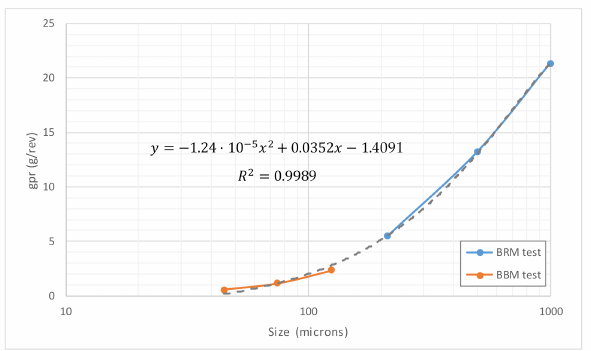
Figure 6. Variation of BBM and BRM w i values with P 100 , Mittersill ore.